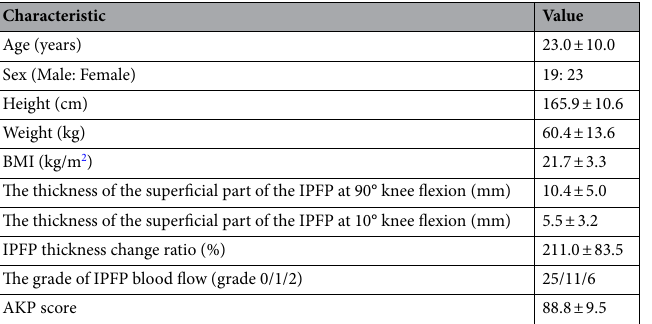
Table 1. Characteristics of the subjects (mean ± SD). SD standard deviation, BMI body mass index, IPFP infrapatellar fat pad, AKP anterior knee pain.